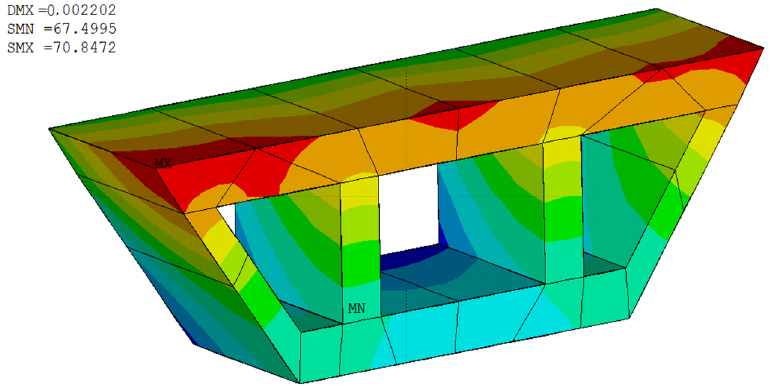
Figure 11. Temperature field in the 3D model cross-section.